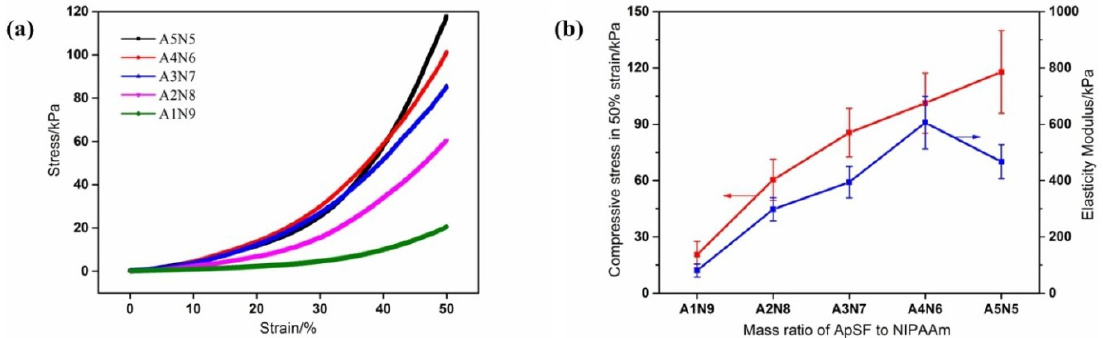
Figure 10. Compression mechanical properties: ( a ) stress–strain curves of composite hydrogels with different ASF content; ( b ) average compressive stress in 50% strain and elasticity modulus with different mixing ratios.